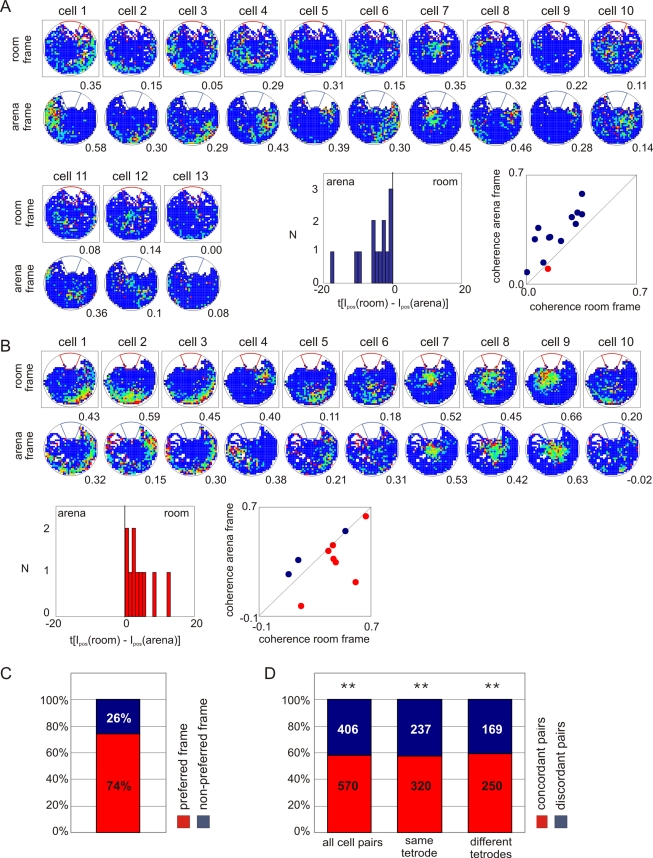
The ensemble preference for one spatial frame dominates two-frame avoidance sessions.An example of an arena-preferring (A) and a room-preferring (B) ensemble. The difference between room frame and arena frame Ipos for each cell indicates an arena preference in Ensemble A and a room preference in Ensemble B. Scatter plot of arena map coherence and room map coherence also indicates the ensemble frame preferences. (C) Most cells had a firing field in the ensemble-preferred frame. (D) Simultaneously recorded cell pairs were more likely to have a concordant frame preference than a discordant frame preference. The tendency for an excess of concordant cell pairs was observed when all cell pairs (z = 5.24; **p<0.0001), cell pairs from the same tetrode (z = 3.52; **p<0.0005), or different tetrodes (z = 3.96; **p<0.0001) were analyzed (χ2<0.15, df = 1, p>0.5).